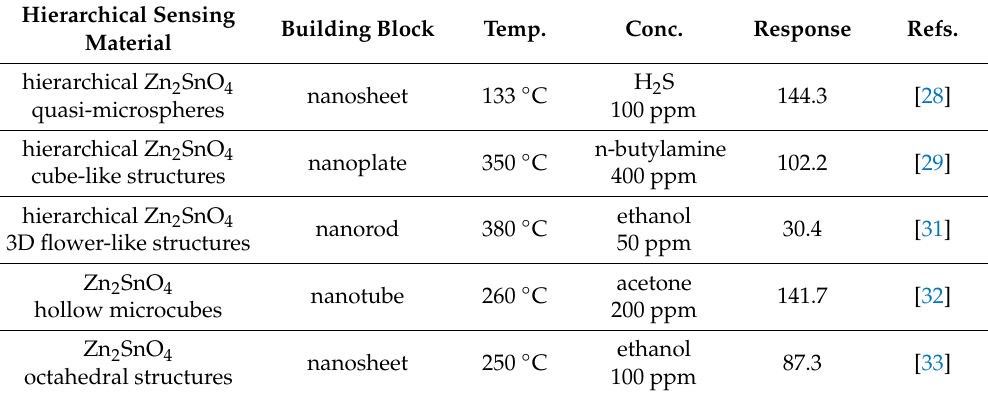
Table 1. Different research on assembling structures towards various aim gas Table 1. Di ff erent research on assembling structures towards various aim gas